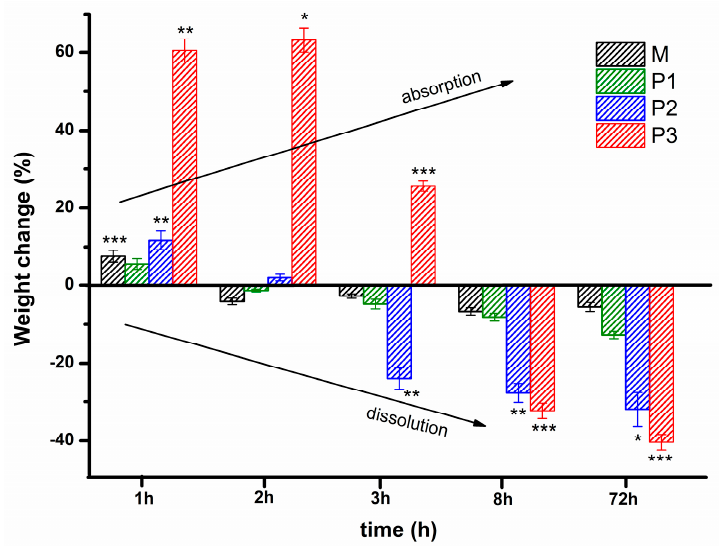
Figure 12. Stability profile for polyurethane/peptide-based carriers at 37 °C in PBS. Statistical significance: *** p < 0.001; ** 0.001 < p < 0.01; * 0.01 < p < 0.05.